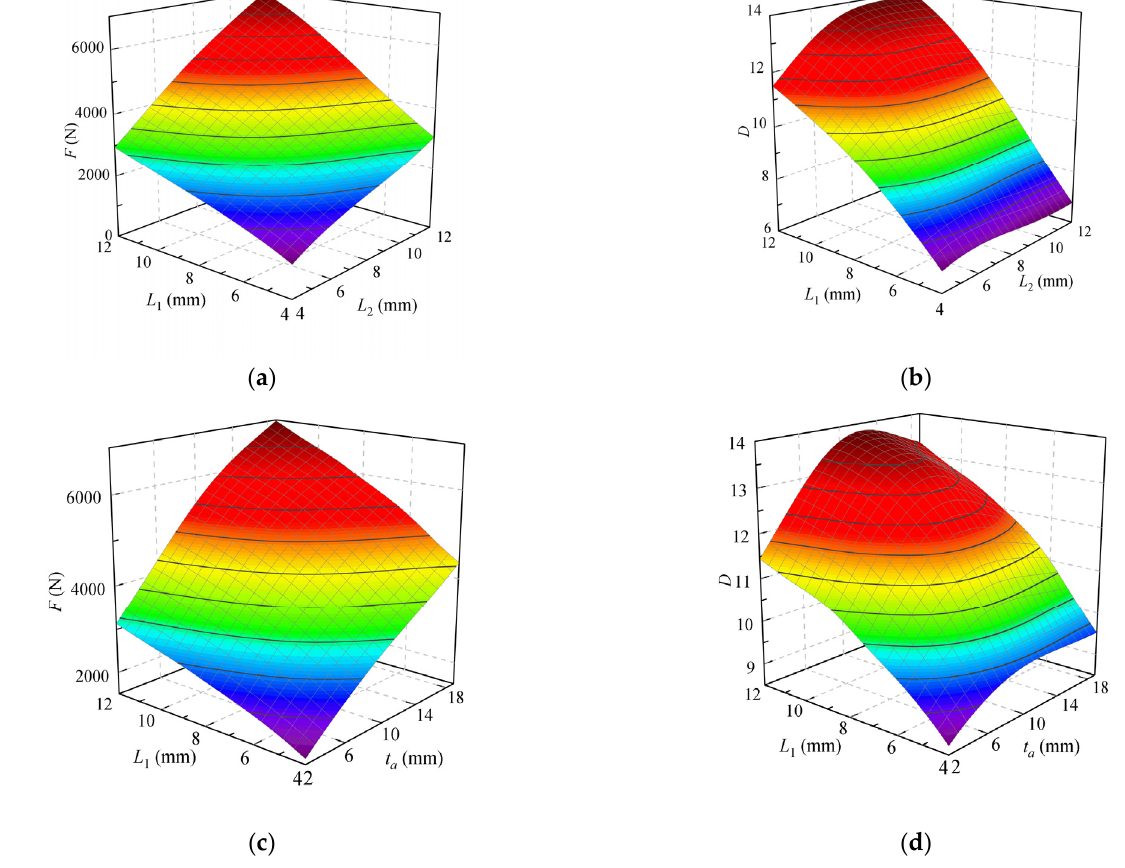
Figure 10. Damping force and dynamic range via the elliptical basis function (EBF) model: ( a ) damping force (with L 1 and L 2 ); ( b ) dynamic range (with L 1 and L 2 ); ( c ) damping force (with t a and L 1 ); ( d ) dynamic range (with t a and L 1 ). Table 3. Prediction comparison of different